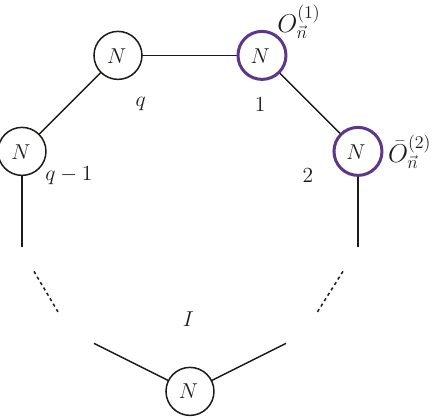
Figure 5. The circular quiver with q nodes associated to the theory A q − 1 . We highlight the nodes at a distance d = 1 in which the operators O (1)